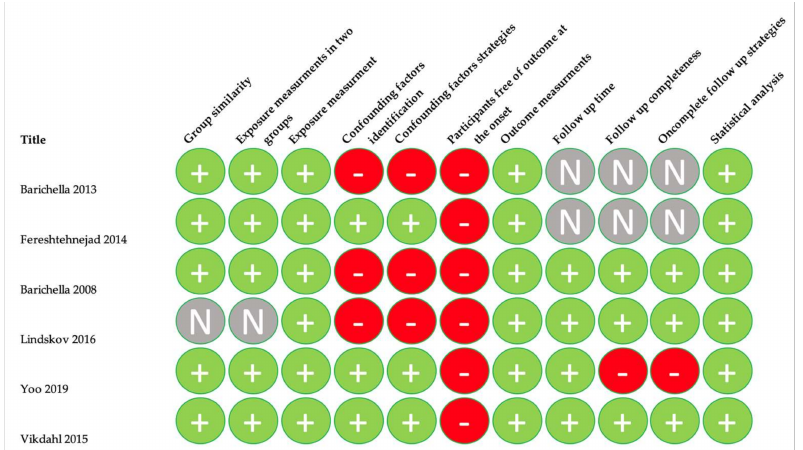
Figure 3. Quality assessment for cohort studies